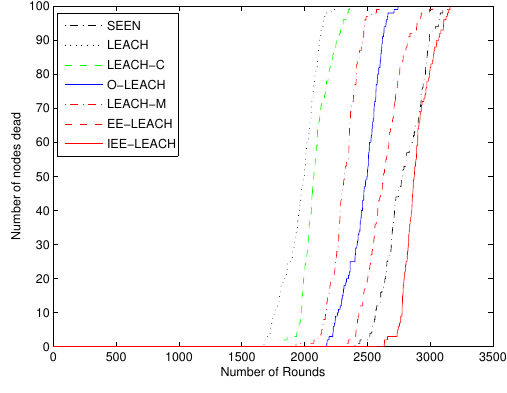
Figure 6. Comparison of life